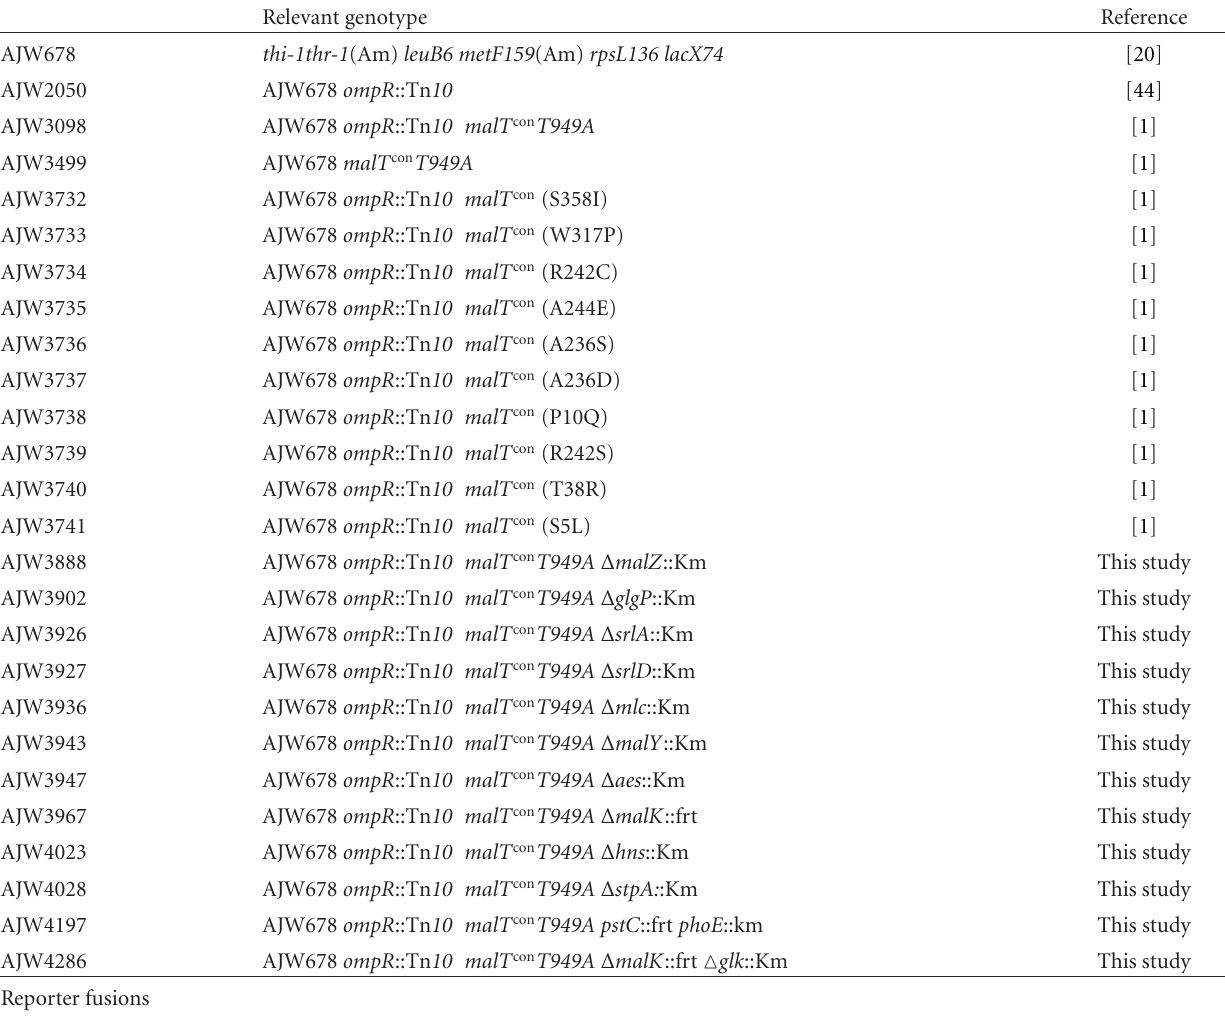
Table 1: Strains, plasmids, and reporter fusions used in this study. Relevant